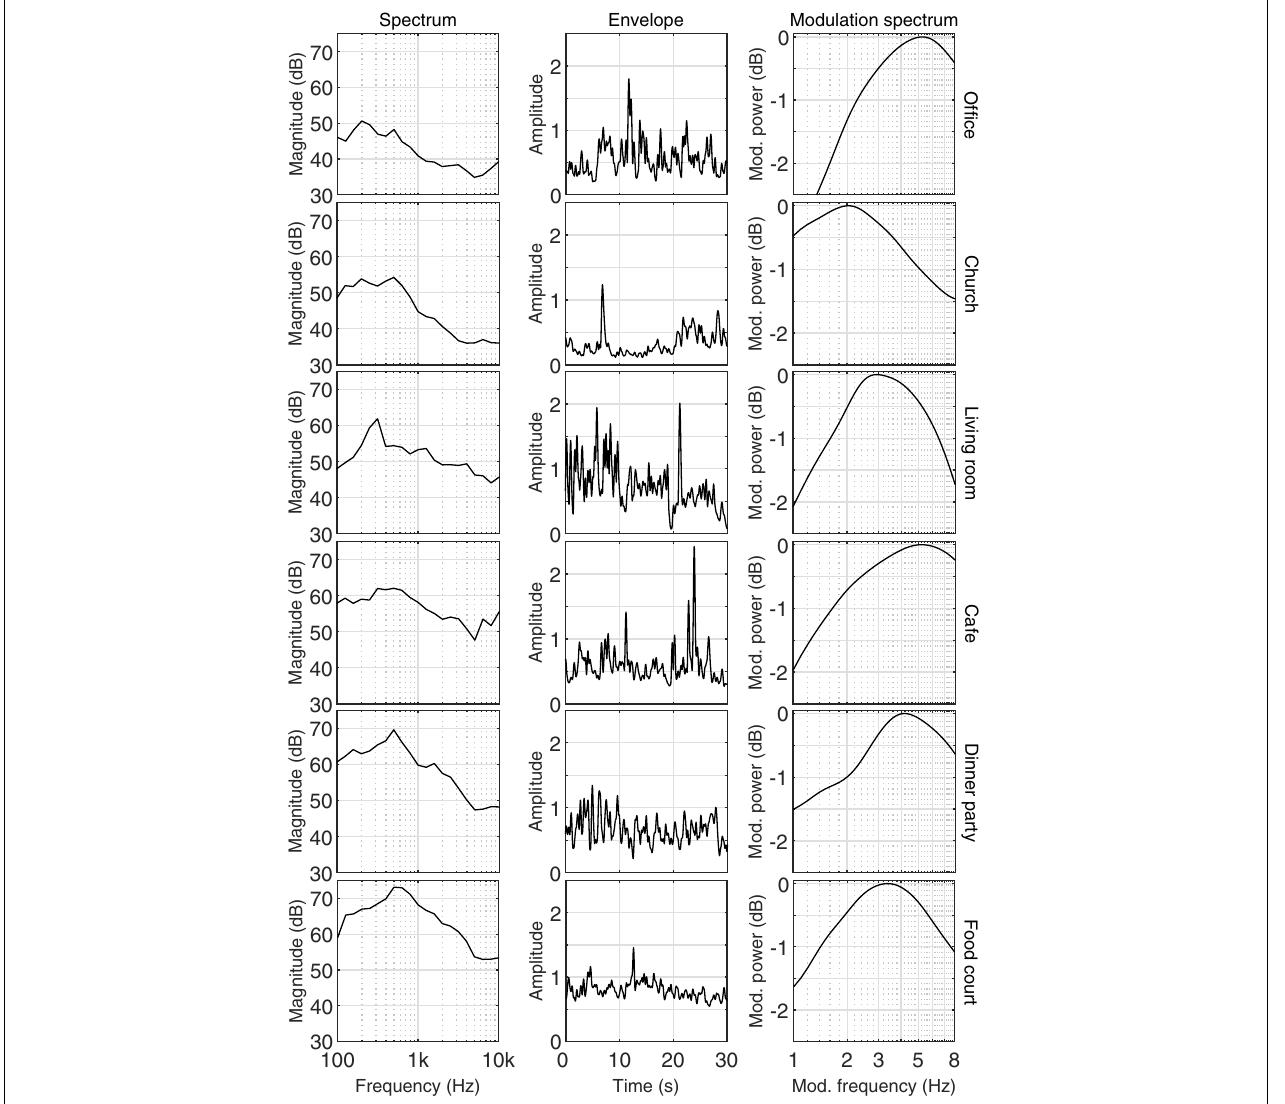
FIGURE A1 | Long-term spectrum in third-octave levels (left column), temporal envelope (30 s example, center column), and modulation spectrum (right column) for the six different acoustic environments derived in free-field.